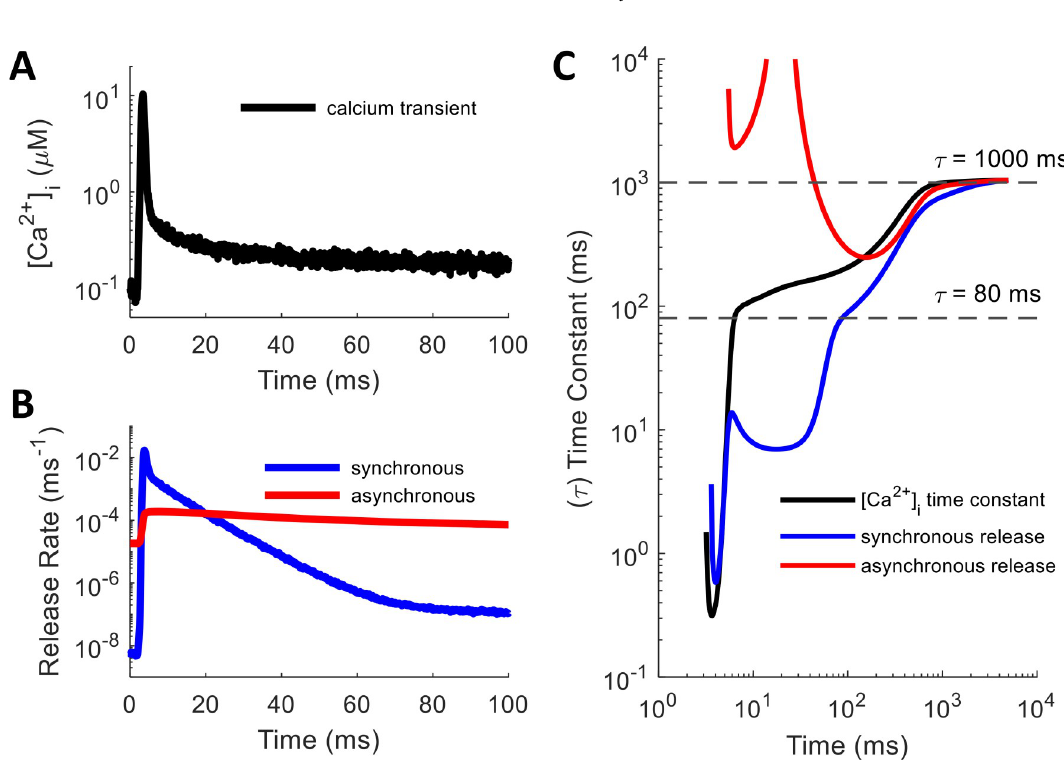
Fig 5. Multi-Exponential Shape of Ca 2+ -Driven Vesicle Release Rate. (A,B) Plots given as semi-log to highlight exponential decay components (straight line segments of profiles). (A) A single, spike-evoked [Ca 2+ ] i transient, which drives (B) the synchronous and asynchronous release rates. (C) Instantaneous time constants for Ca 2+ , synchronous, and asynchronous curves, calculated from the well-mixed model (see Eq (2)). Long release rate time constants (around 80 ms and 1000 ms; dashed lines) follow Ca 2+ curve due to slow un-buffering of latent Ca 2+ . Asynchronous starts high because fast and slow components have comparable magnitude and become conflated; it goes up to infinity where additive effects cause the curve to flatten.